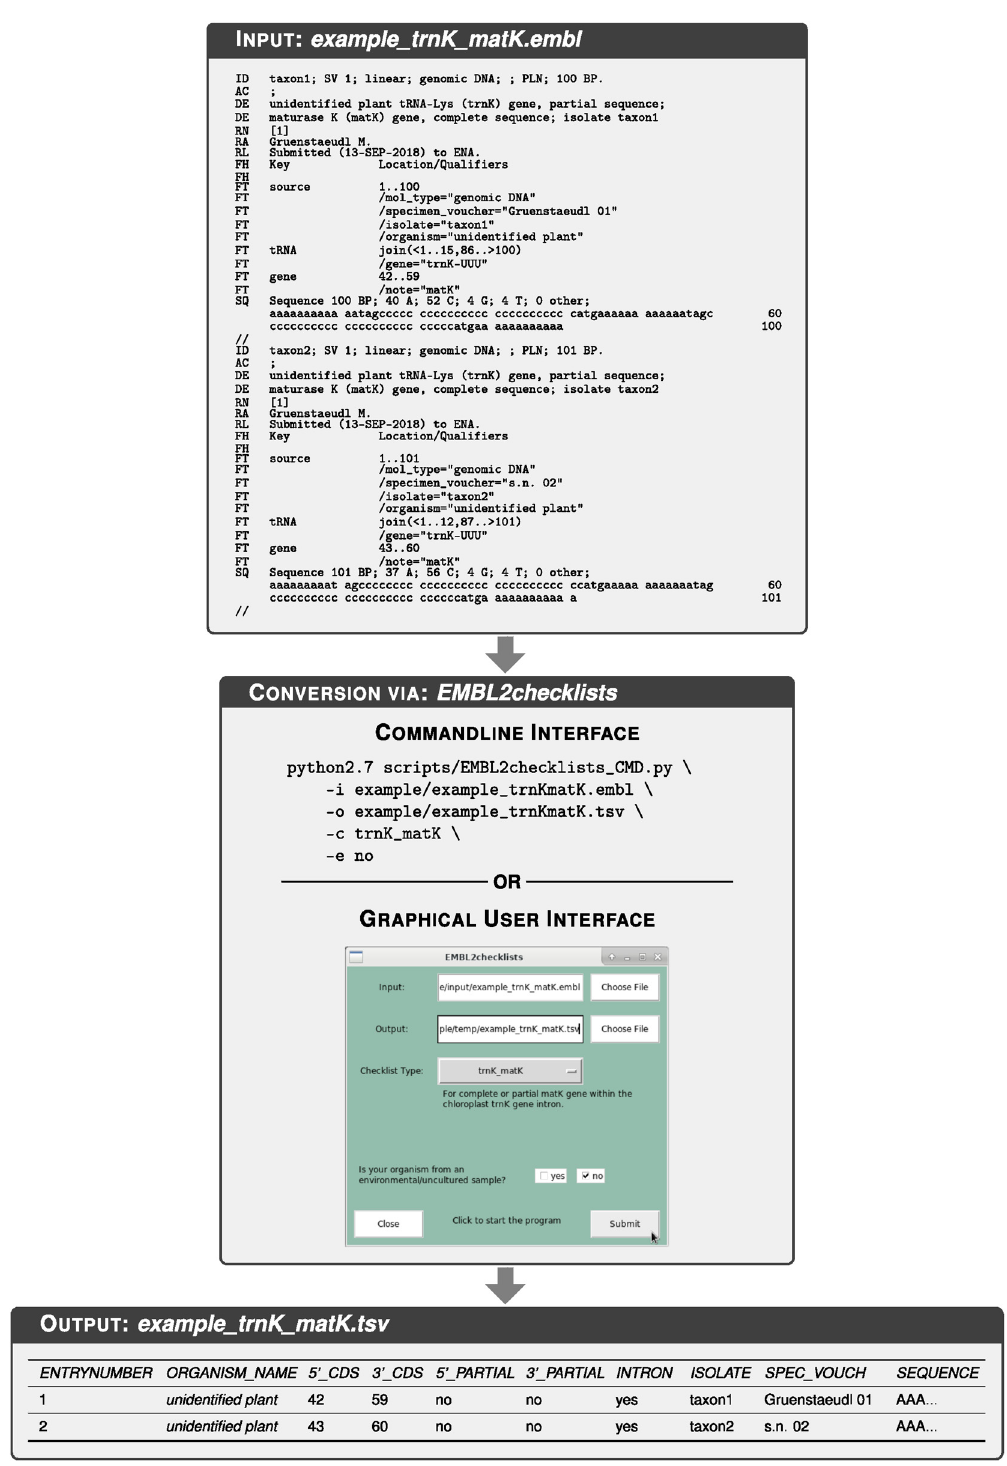
Fig 4. Overview of the conversion process from an EMBL-formatted flat file to a submission-ready Webin checklist via the application of EMBL2checklists. Name and content of the input and output files displayed are identical to the corresponding example test files co-supplied with the